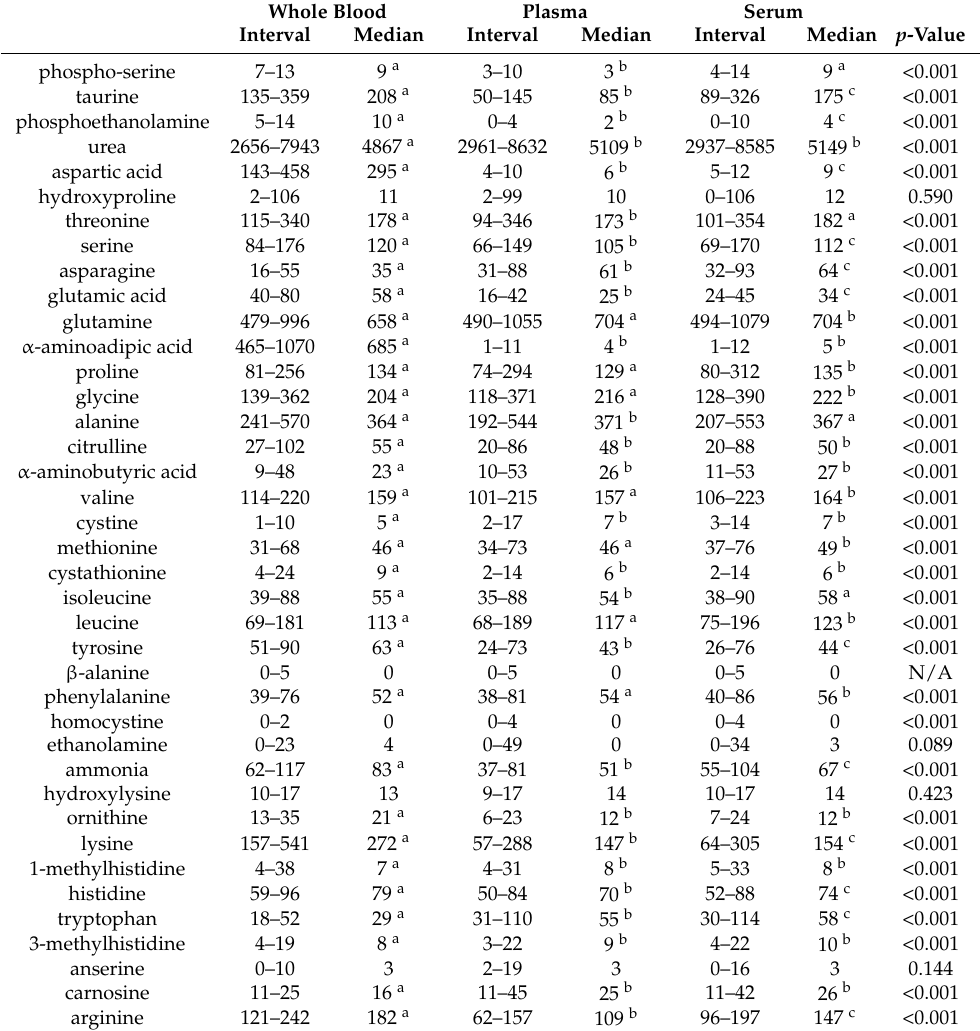
Table 3. Comparison of amino acid concentrations ( µ M) in whole blood, plasma, and serum of healthy dogs ( n =